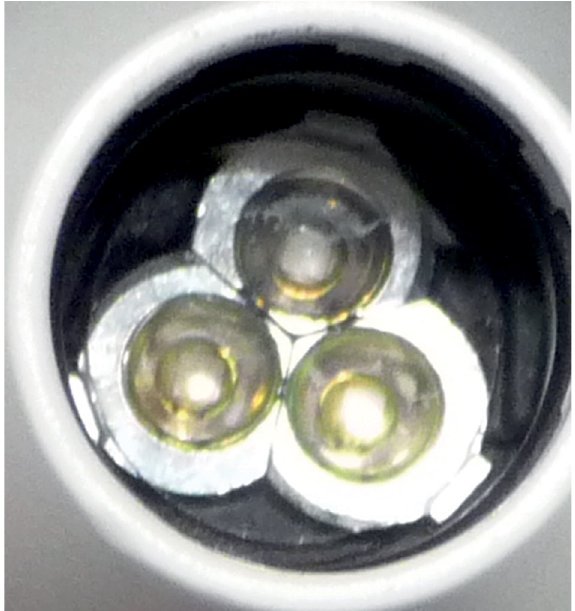
Figure 29. Image of the construction of the emitting elements in Ivoclar’s Bluephase STYLE curing light.